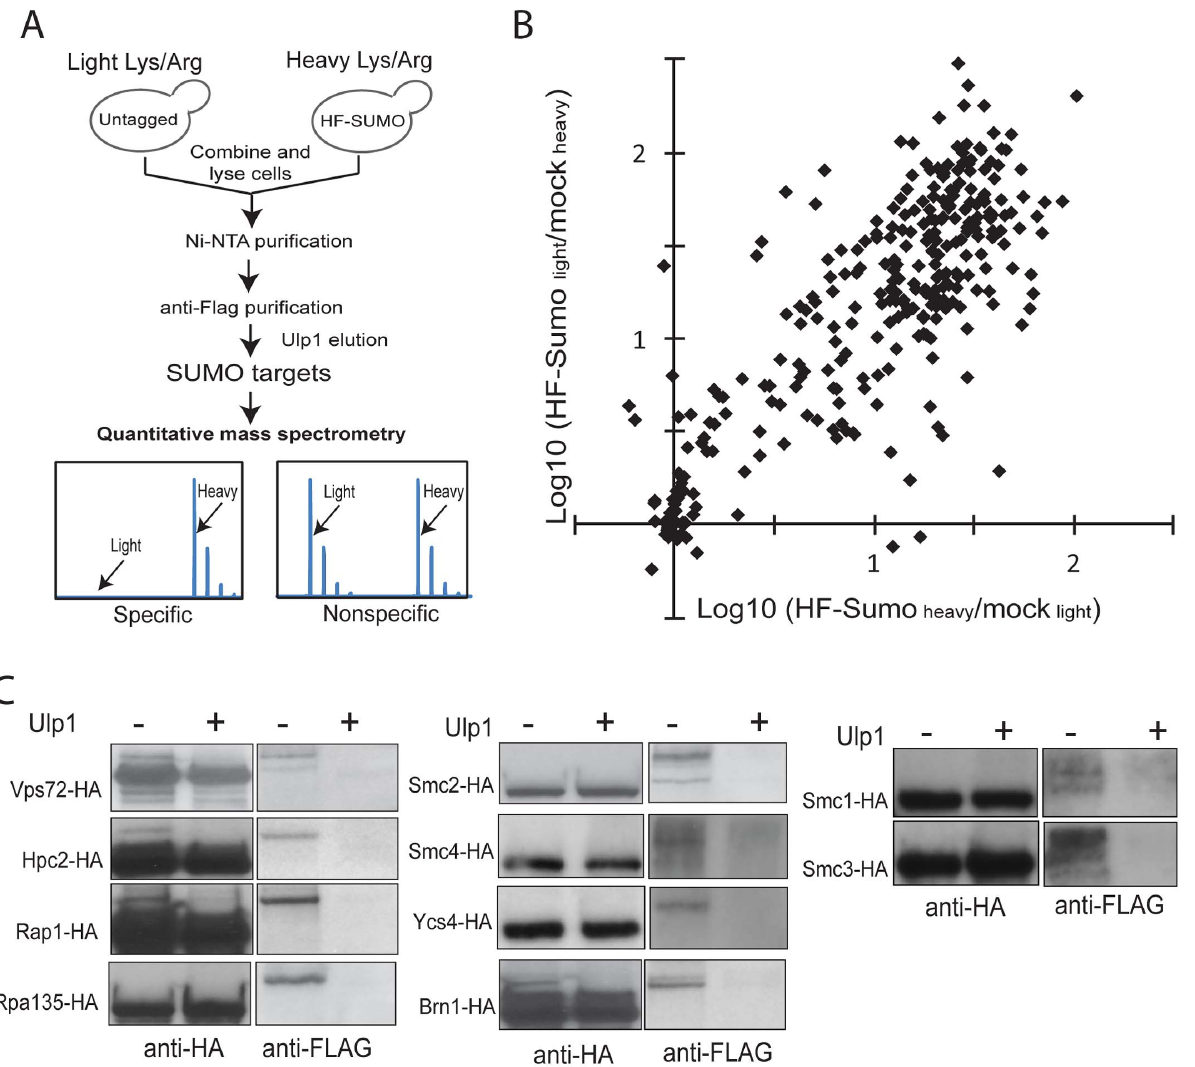
Figure 1. A new quantitative proteomics technology to characterize the SUMO-proteome. A) Method to identify and quantify sumoylated proteins using SILAC and MS. Untagged cells and HF-SUMO cells were combined for purification of sumoylated proteins. Ulp1 was used to elute sumoylated proteins for MS analysis. B) Scatter plot of the identified proteins based on two replicate experiments. The majority of the proteins show a large abundance ratio between HF-SUMO purification versus mock purification, indicating a highly purified sample. Candidate SUMO targets are identified based on at least 10-fold abundance ratio between HF-SUMO and mock sample in both replicate experiments. C) Western blot analysis of several SUMO targets confirmed them being sumoylated. Ulp1 treatment was used to treat half of the anti-HA immunoprecipitated